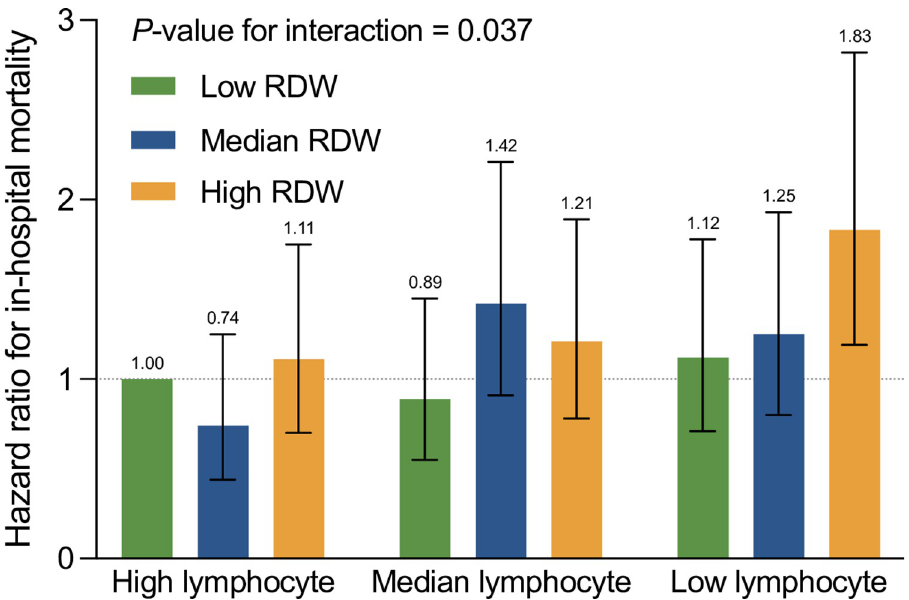
Fig 4. Risk of in-hospital mortality according to lymphocyte percentage and RDW level. Hazard ratios were adjusted for age, sex, smoking history, hypertension history, diabetes history, aortic valve replacement history, anatomical classification, etiology, aorta diameter, onset time and hospital centers. RDW, red blood cell distribution width. https://doi.org/10.1371/journal.pone.0283008.g004 lymphocyte percentage and RDW categories were combined, there was an obvious association between decreasing lymphocyte percentage and elevated RDW ( Fig 4 and Table 3 ). Patients with low lymphocyte percentage and high RDW were at a higher risk of all-cause in-hospital mortality versus those with high lymphocyte percentage and low RDW (HR 1.83, 95% CI 1.19–2.82). Collectively, our data demonstrated that lymphopenia combined with the elevation of RDW could serve as a novel candidate for predicting in-hospital AAD mortality.